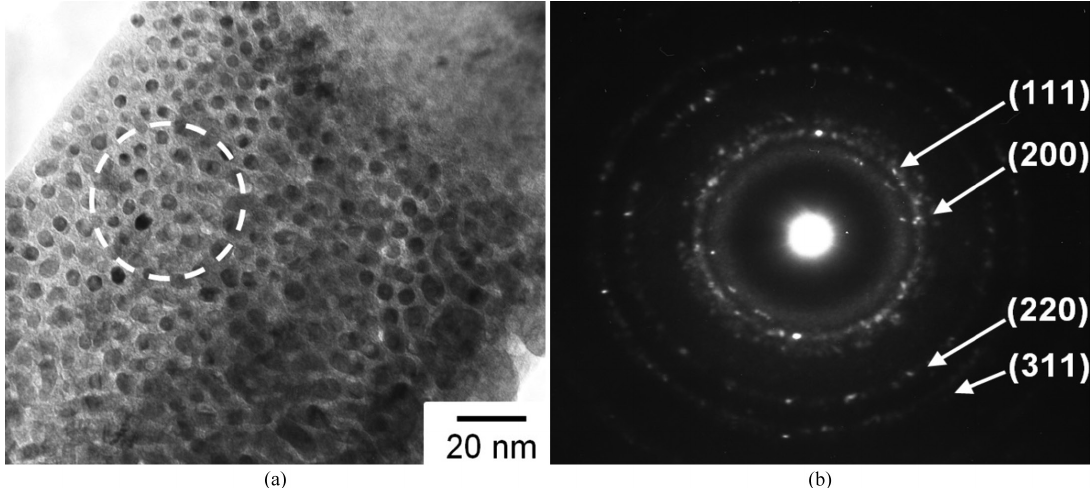
Figure 7. TEM images of the melt-spun Ag